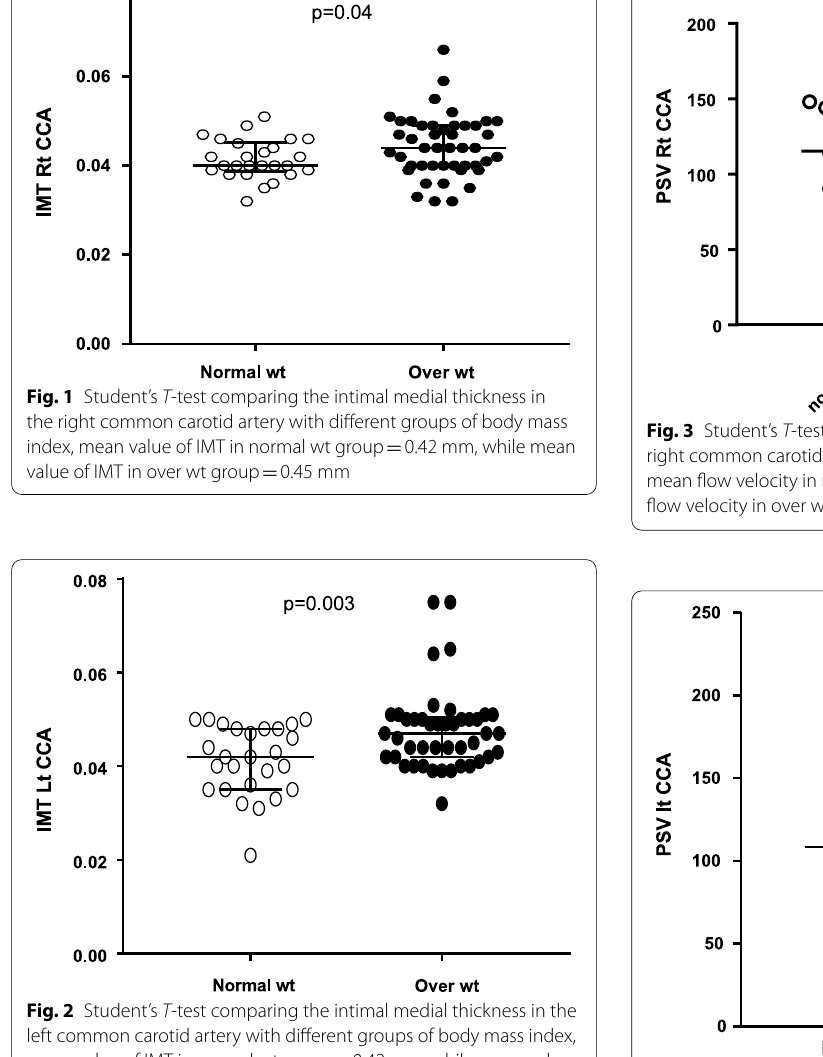
Fig. 4 Student’s T -test comparing the peak systolic velocity in the left common carotid with different groups of body mass index, mean flow velocity in normal wt group 117.29 cm/s, while mean flow = velocity in over wt group 104.55 =